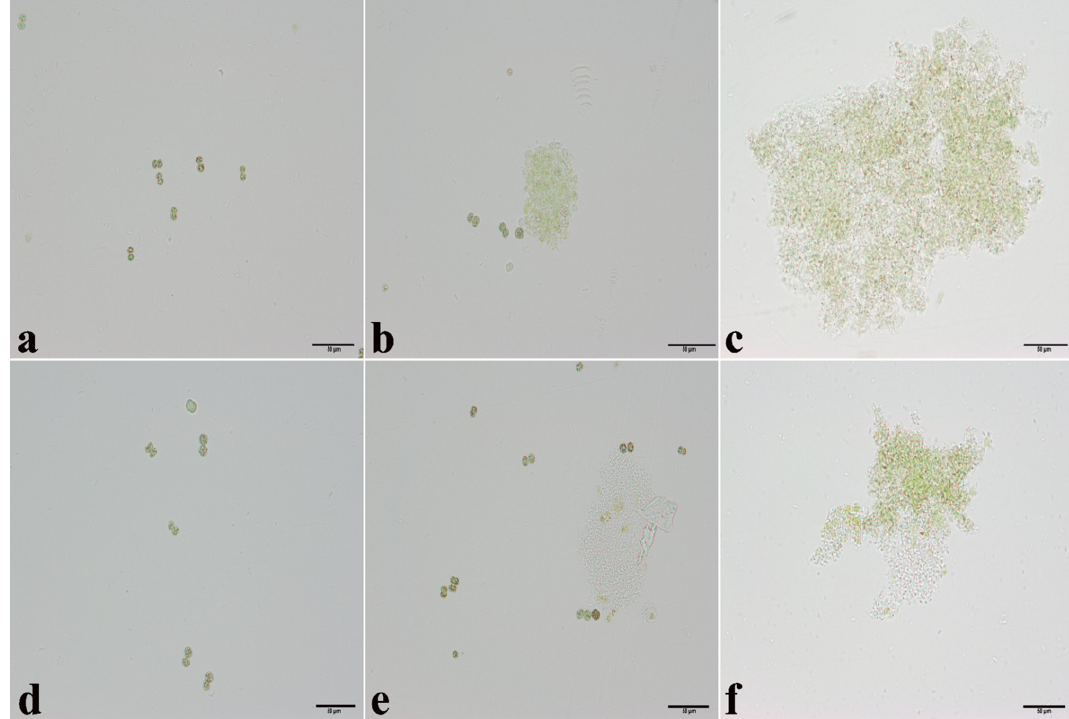
Figure 10. The optical microscope observations of Microcystis aeruginosa treated by the algicidal bacteria 39 # ( a – c ) and 91 # ( d – f ). a , d : Normal algae. b , e : Changes after 1 day of inoculation of 39 # and 91 # bacterial solution, respectively. c , f : Changes after 2 days of inoculation of 39 # and 91 # bacterial solution, respectively.